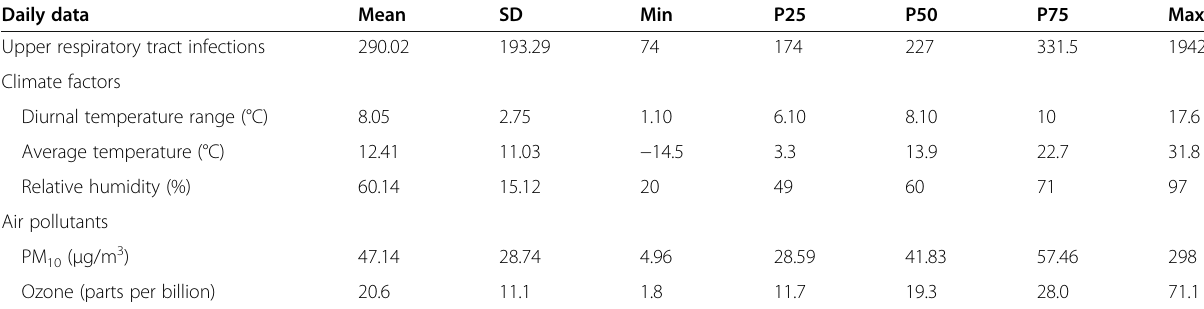
Table 2 Summary statistics of daily emergency room visits for acute upper respiratory tract infections, and climate factors and air pollutants in Seoul, Korea, 2009 to 2013 Daily